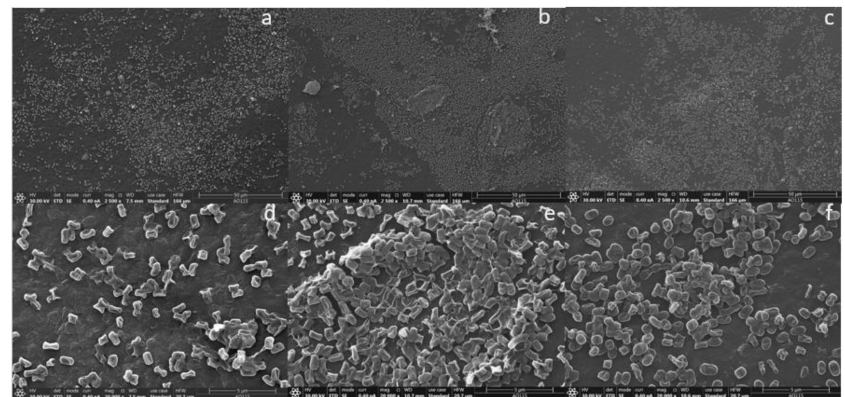
Figure 6. SEM micrographs of Streptomyces sp. attached to the polyethylene film surface. Unpretreated plastic film (UPF) at 2500 × magnification ( a ) and 20,000 × magnification ( d ). Weathered plastic film (WPF) at 2500 × magnification ( b ) and 20,000 × magnification ( e ). Buried plastic film (BPF) at 2500 × magnification ( c ) and 20,000 × magnification ( f ).